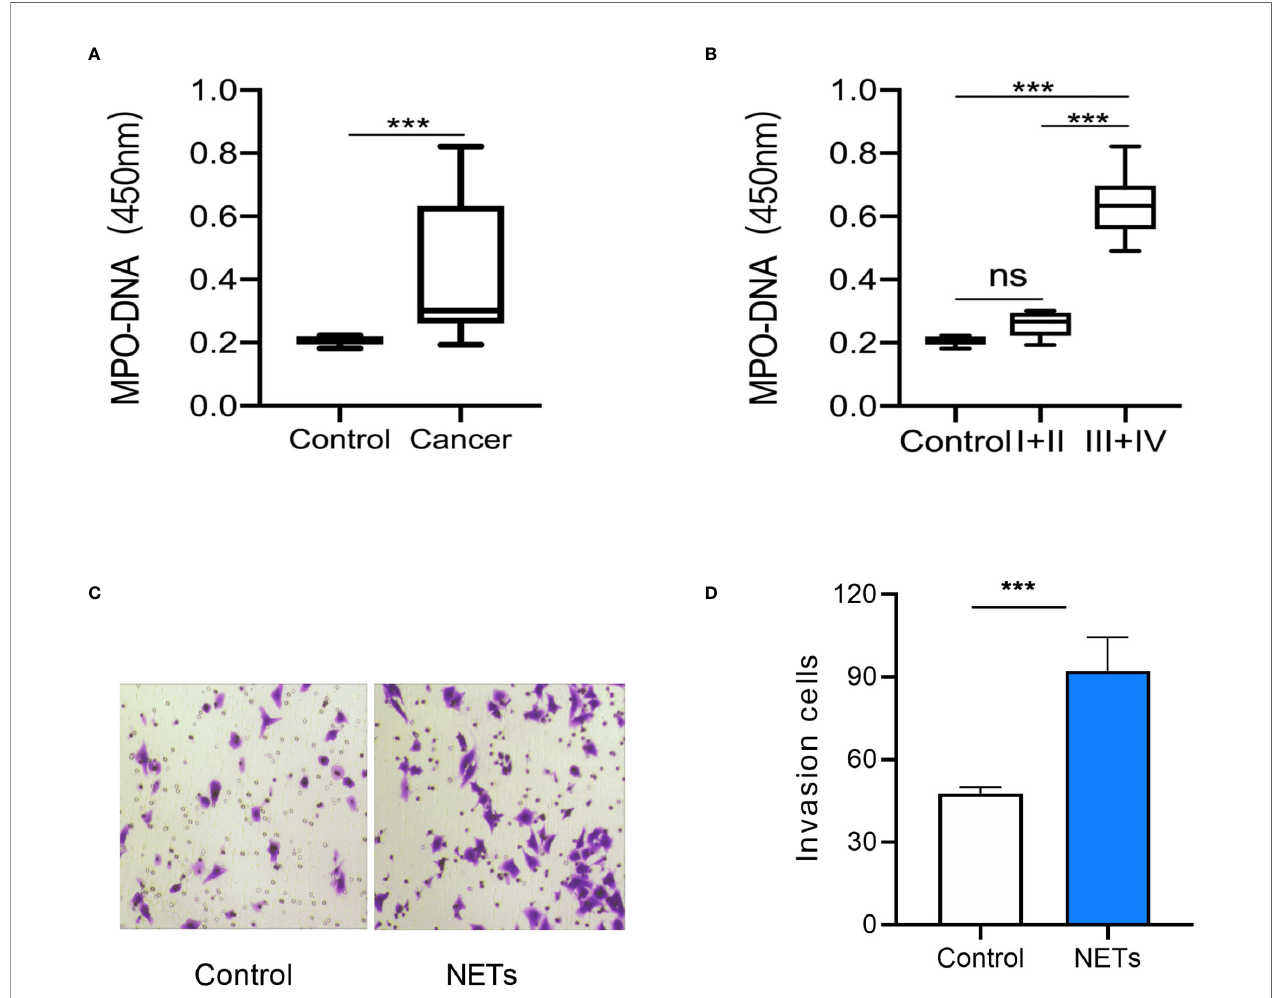
FIGURE 1 | NETs expression in peripheral blood of gastric cancer patients and its effect on gastric cancer cells. (A) NETs expression in peripheral blood of GC patients and healthy controls. (B) NETs expression in peripheral blood of GC patients in different stages. (C) Representative images of the invasion assay. (D) The analysis results of invasive AGS cells treated by NETs. For panels (A, B) , Control group, n = 10; GC group, n = 41; I+II group, n = 20; III + IV group, n = 21; for panel (D) , n = 4; *** p <